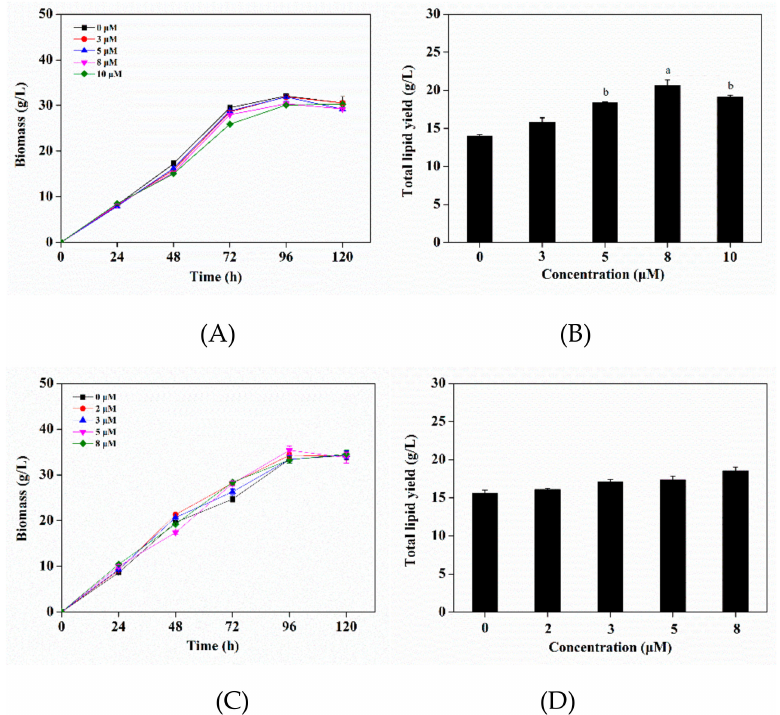
Figure 4. E ff ect of di ff erent concentration of triclosan added at 24 h on ( A ) biomass, ( B ) total lipid yield, and at 48 h on ( C ) biomass, ( D ) total lipid yield. Significant di ff erence between control and triclosan treatment group is indicated at p < 0.05 (a), p < 0.01 (b) or p < 0.001 (c) level. All data are expressed as mean ± S.D. of three independent